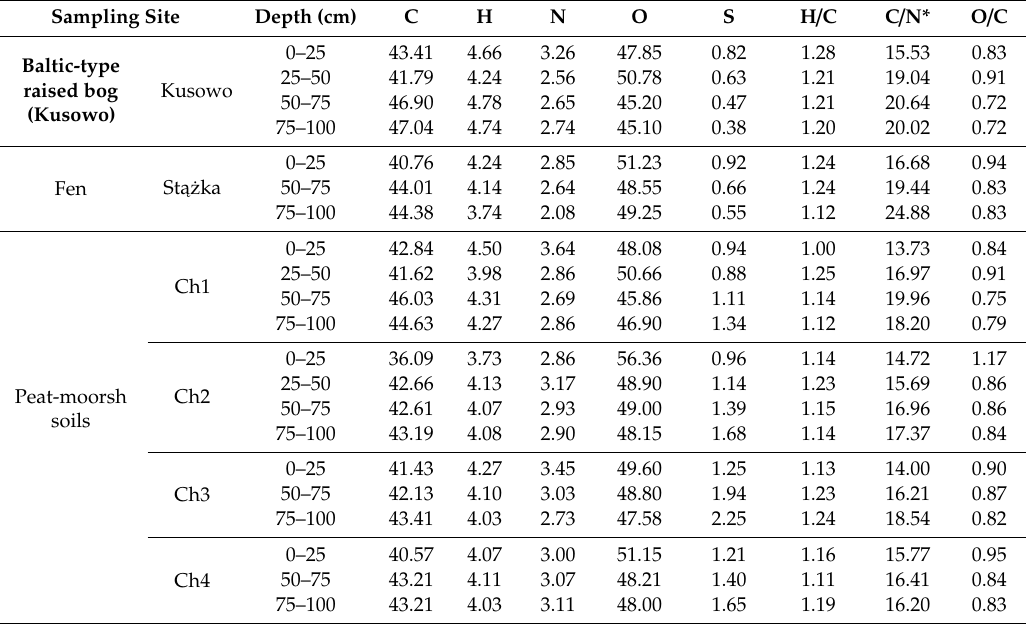
Table 6. Elemental analysis (wt.%) and atomic ratios of humic acids (HAs).